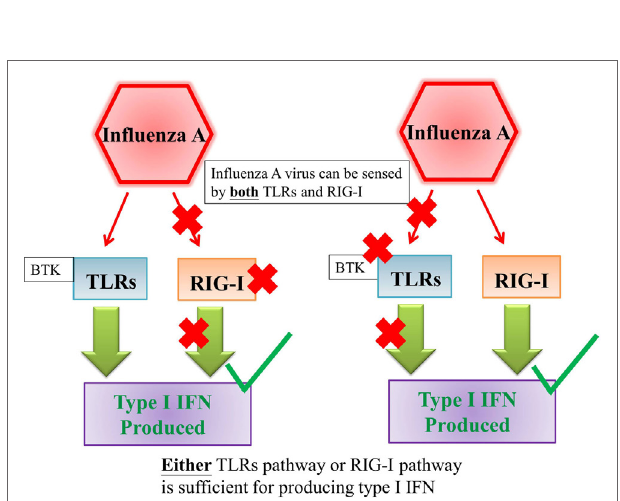
FigUre 2 | Either TLRs pathway or RIG-I pathway is sufficient for producing type I interferon against influenza A virus infection. Influenza A virus can be sensed by both TLRs and RIG-I and either TLRs pathway or RIG-I pathway is sufficient for producing type I interferon against influenza A virus infection (22). Abbreviations: TLRs, toll-like receptors; RIG-I, retinoic acid-inducible gene I; IFN, interferon.